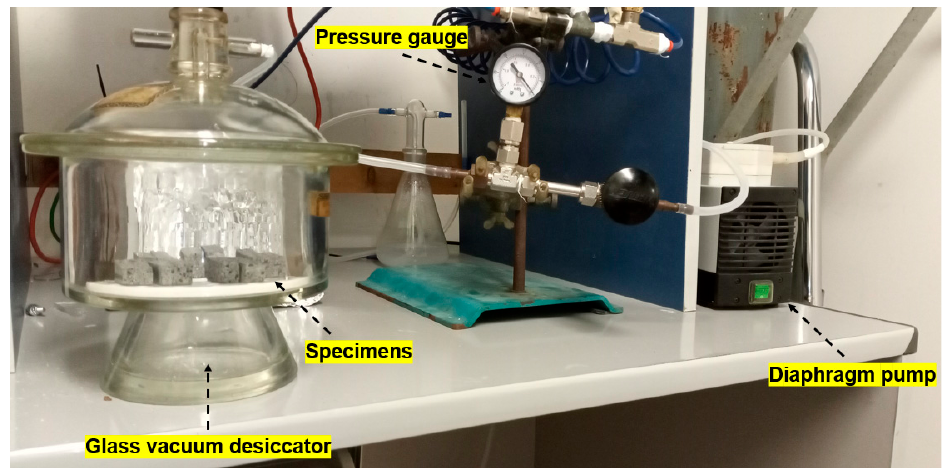
7 of 25 Figure 4. Set of specimens for experimental testing.